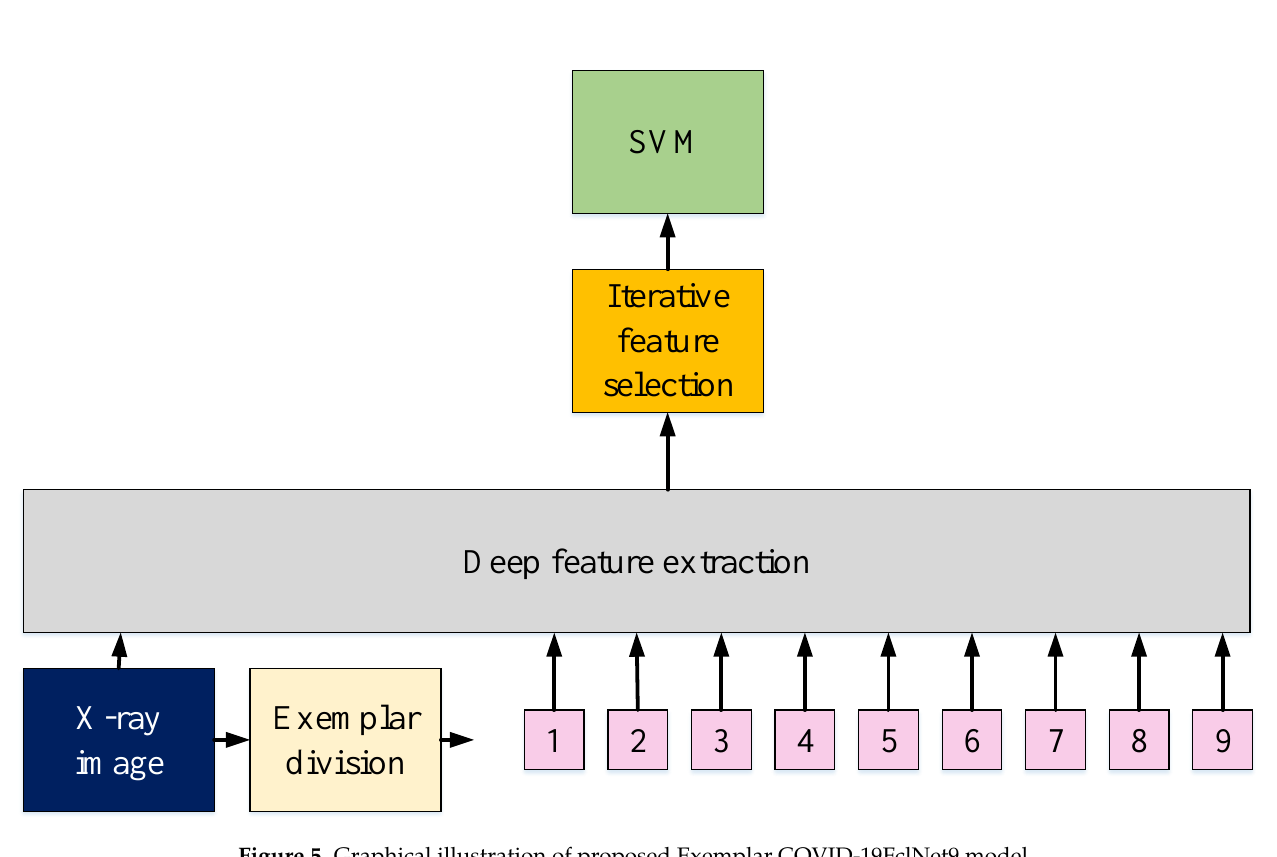
Figure 5. Graphical illustration of proposed Exemplar COVID-19FclNet9 model. Figure 5 summarises the presented model. The pseudocode of the proposed Exem- plar COVID-19FclNet9 X-ray classification model is given in Algorithm 1. Algorithm 1 The algorithm used to implement proposed Exemplar COVID-19FclNet9 model